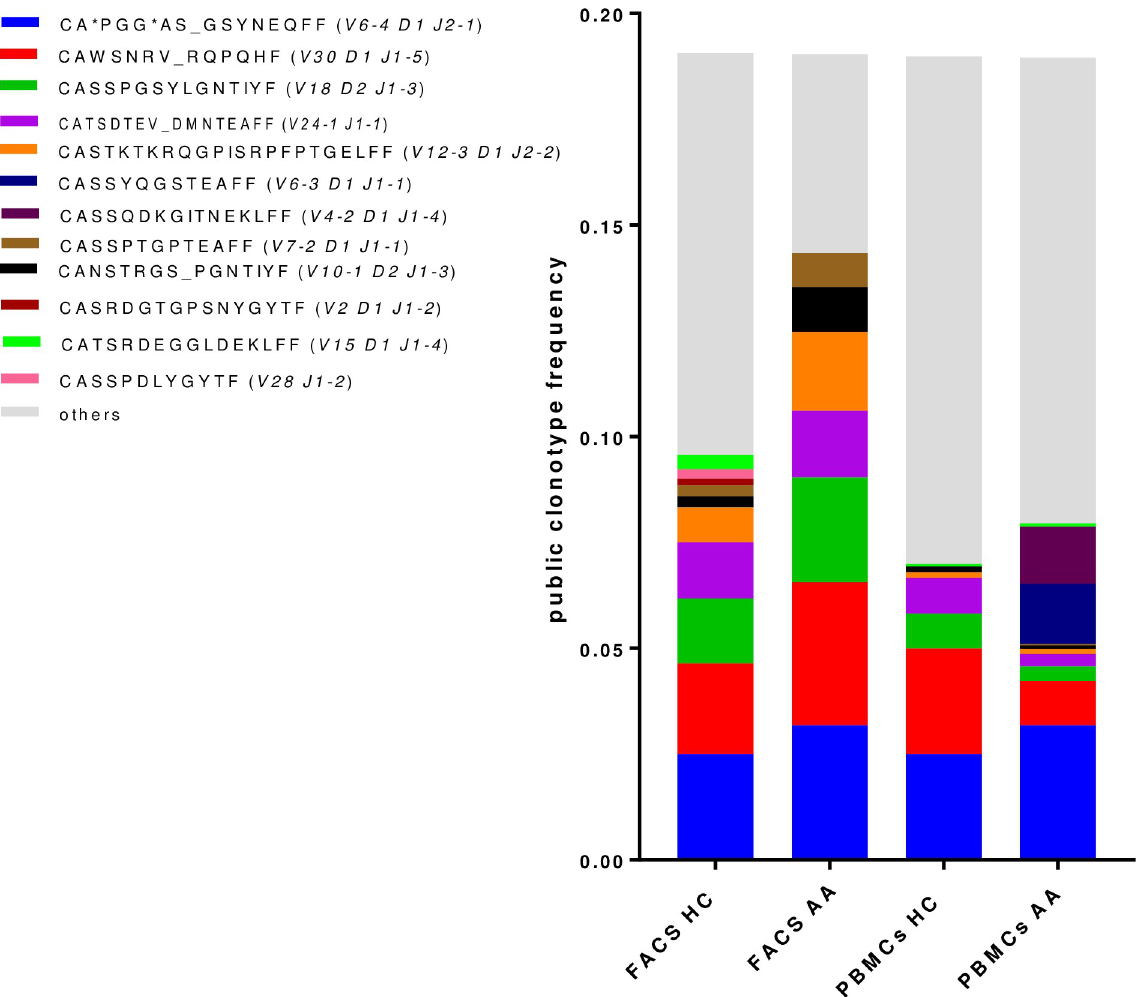
Fig 4. Distribution of public clonotypes in Tregs and total T-cells of patients and HCs. The most frequent sequences are allocated individual colours defined in the key, while the others are combined and shown in grey. PBMC: total blood cells. FACs: Sorting for Treg cells by FACs